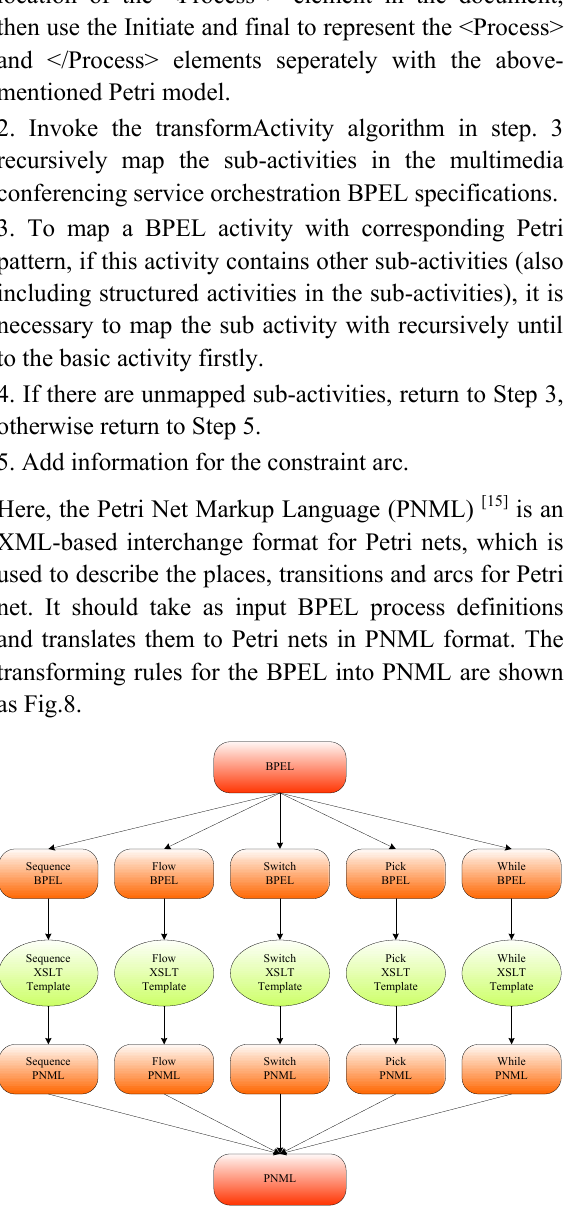
Fig.8. Transforming rules from BPEL to PNML rules express how